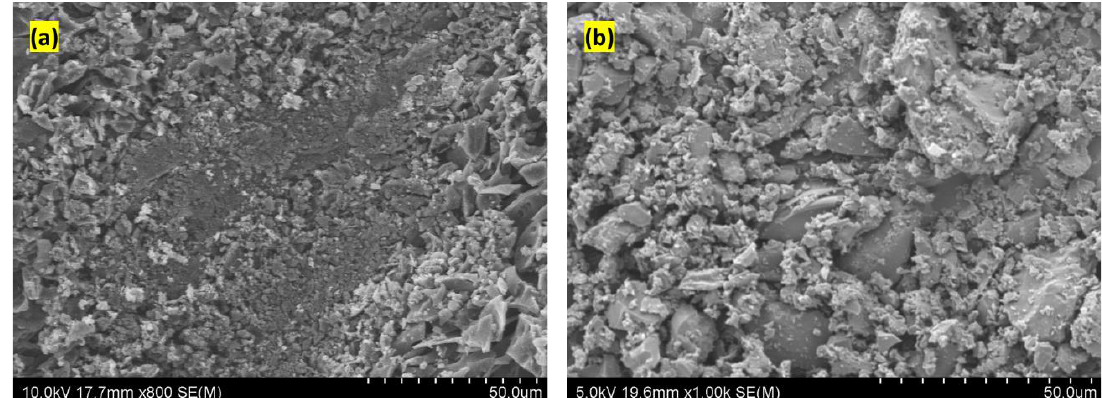
Figure 1. SEM images of biochar: ( a ) before, and ( b ) after size-reduction.